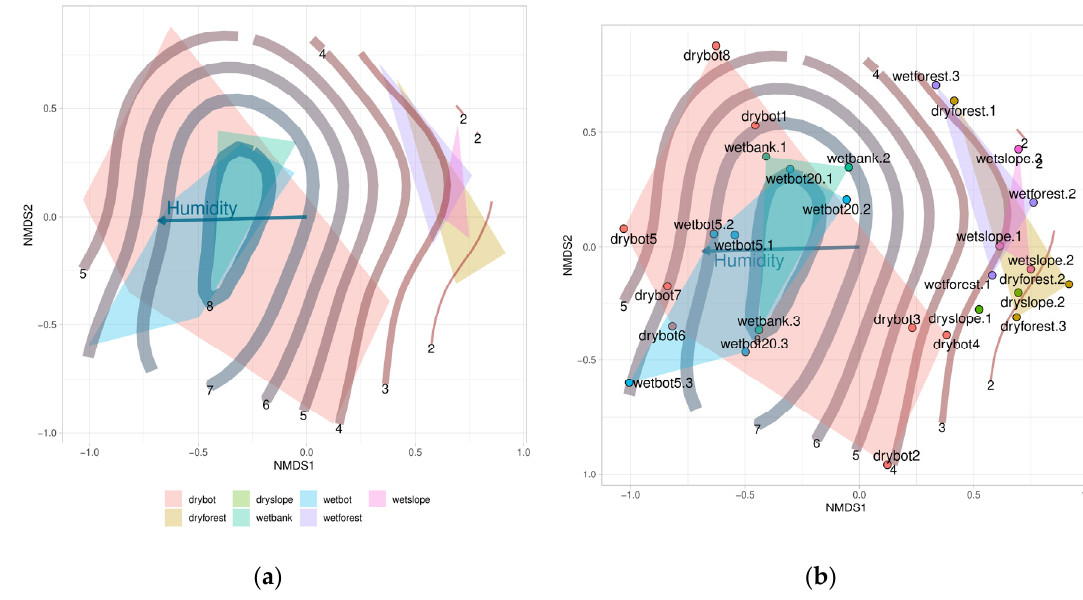
Figure 4. Non-metric multidimensional scaling plot of sampling sites in the forested ravine in humid and drought periods together with the gradient of humidity superimposed (stress: 0.154, goodness-of-fit: nonmetric R 2 = 0.976, linear R 2 = 0.874). ( a ) Only the habitat areas in the nMDS space; ( b ) the location of each site in the nMDS space. For details, see Figure 3.